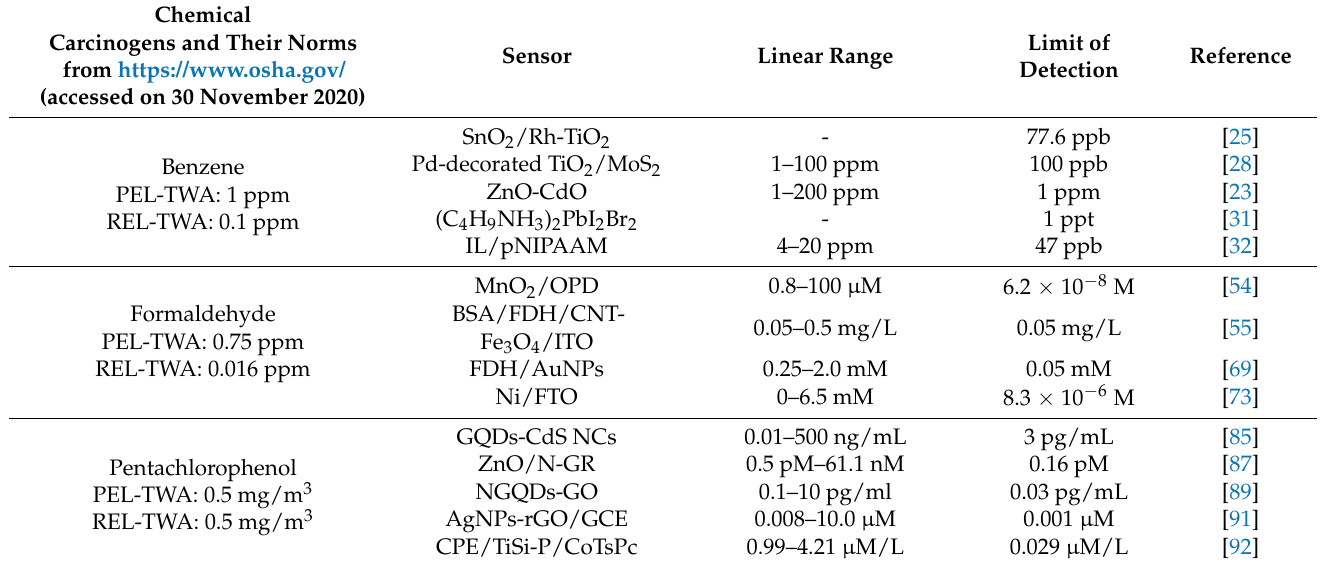
Table 3. Comparison of the performance of the selected sensors with different electrode materials in detecting leukemia-inducing chemical